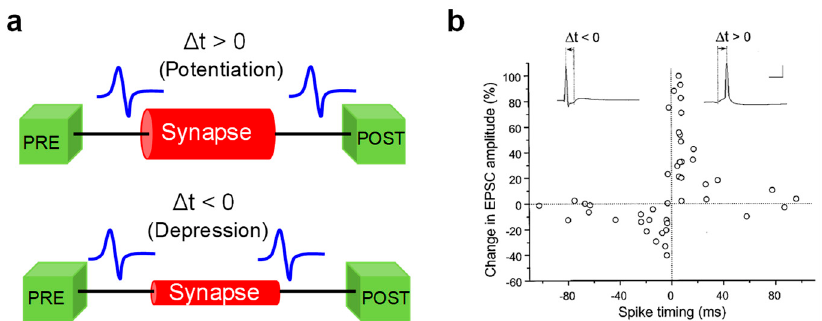
Figure 2. ( a ) Sketch of the spike-timing-dependent plasticity (STDP) learning rule. If the PRE spike arrives just before the POST spike at the synaptic terminal ( ∆ t > 0), the synapse undergoes a potentiation process, resulting in a weight (conductance) increase ( top ). Otherwise, if the PRE spike arrives just after the POST spike ( ∆ t < 0), the synapse undergoes a depression process, resulting in a weight (conductance) decrease ( bottom ). ( b ) Relative change of synaptic weight as a function of the relative time delay between PRE and POST spikes measured in hippocampal synapses by Bi and Poo. Reprinted with permission from [38]. Copyright 1998 Society for Neuroscience.